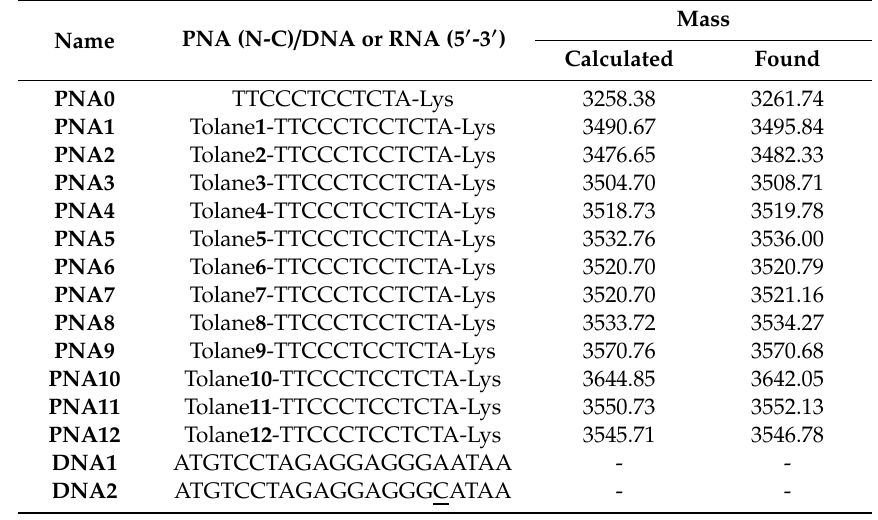
Table 1. PNA and DNA sequences used for studying the e ff ect of tolane molecules on UV-melting temperature